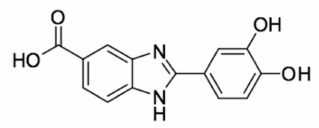
Figure 1. Oxisol